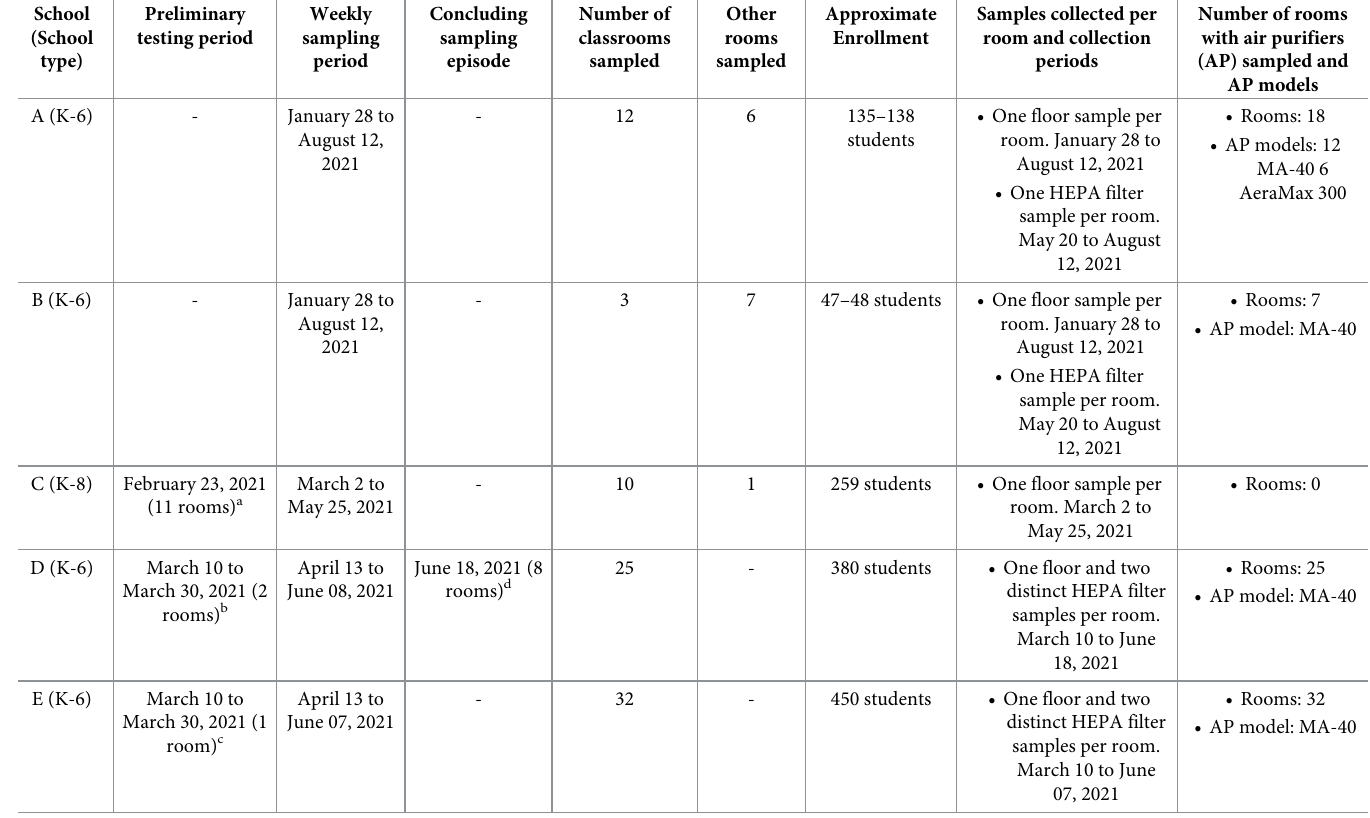
Table 1. HEPA filter and floor environmental monitoring strategies for the detection of SARS-CoV-2 in five K-6 and K-8